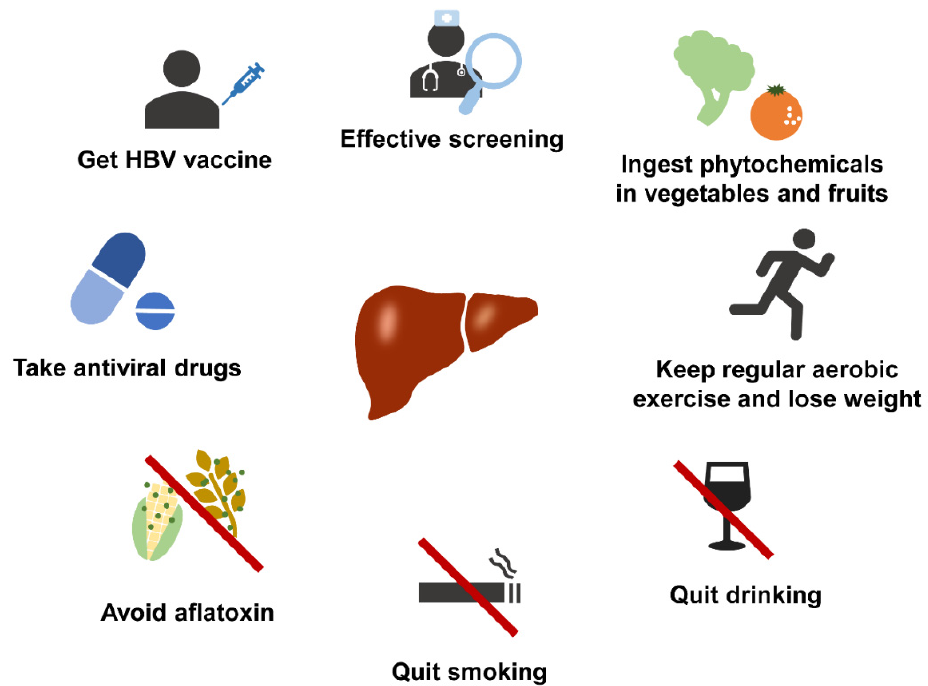
Figure 4. Methods to reduce the incidence of HCC.